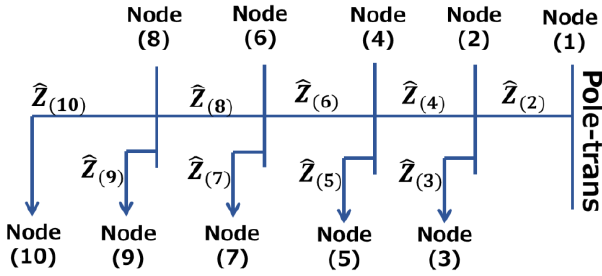
Figure 2. Five T-nodes in the model for the case study.